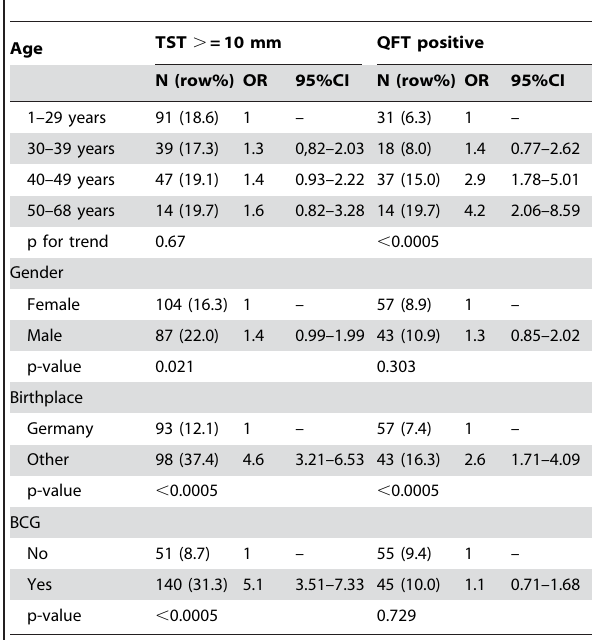
Table 3. Adjusted Odds Ratios for TST and QFT depending on age, gender, migration, or BCG